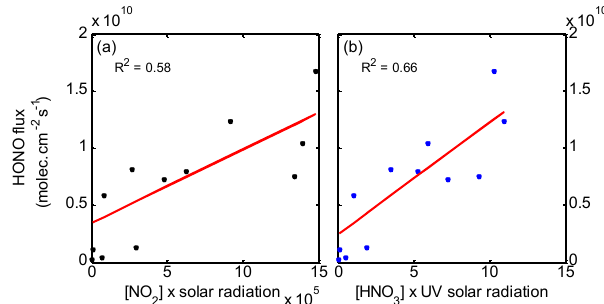
Figure 11. Correlation analysis of (a) HONO flux vs. [NO 2 ] × solar radiation and (b) HONO flux vs. [HNO 3 ] × UV solar radiation based on the hourly average sunny day diurnal